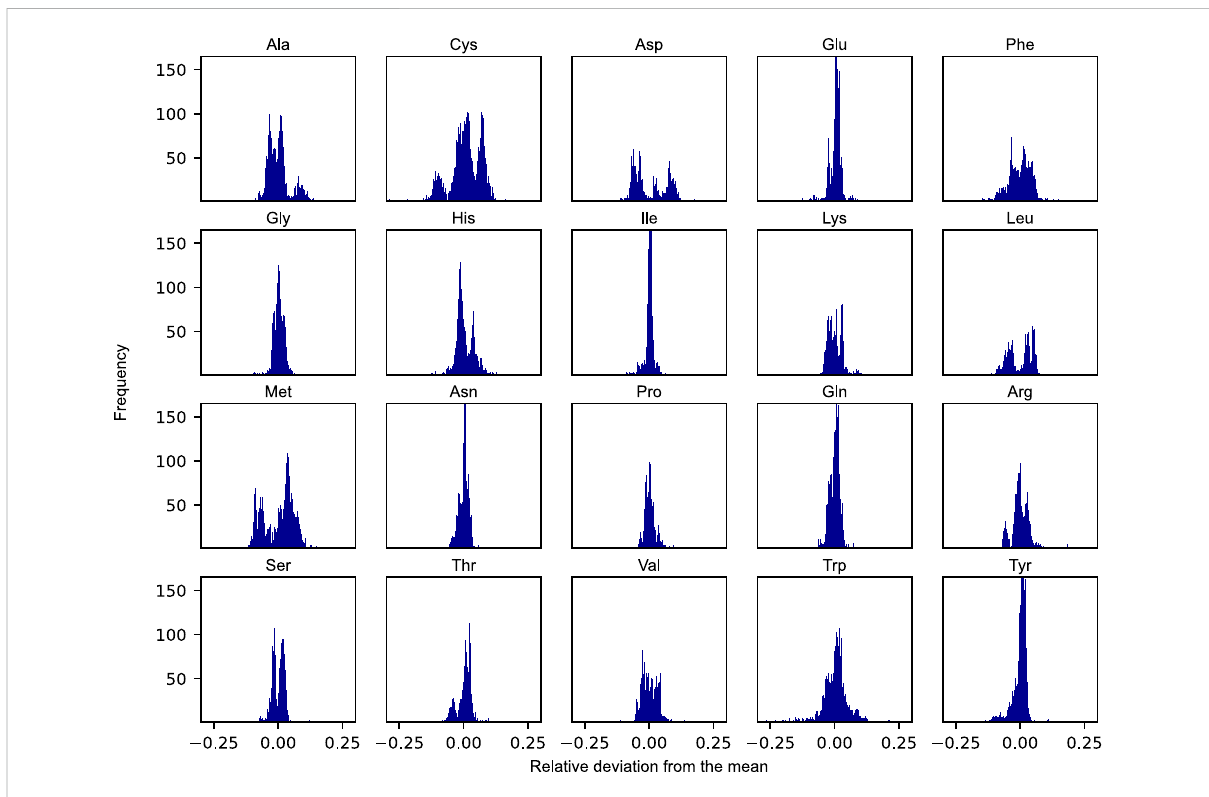
FIGURE 3 Distributions of the relative deviations from the mean of proteinogenic amino acids across N = 5, 000 randomly sampled nutrient conditions. Each condition was de fi ned by a unique combination of viable nutrient sources belonging to each of the four elemental classes: carbon, nitrogen, phosphorus, and